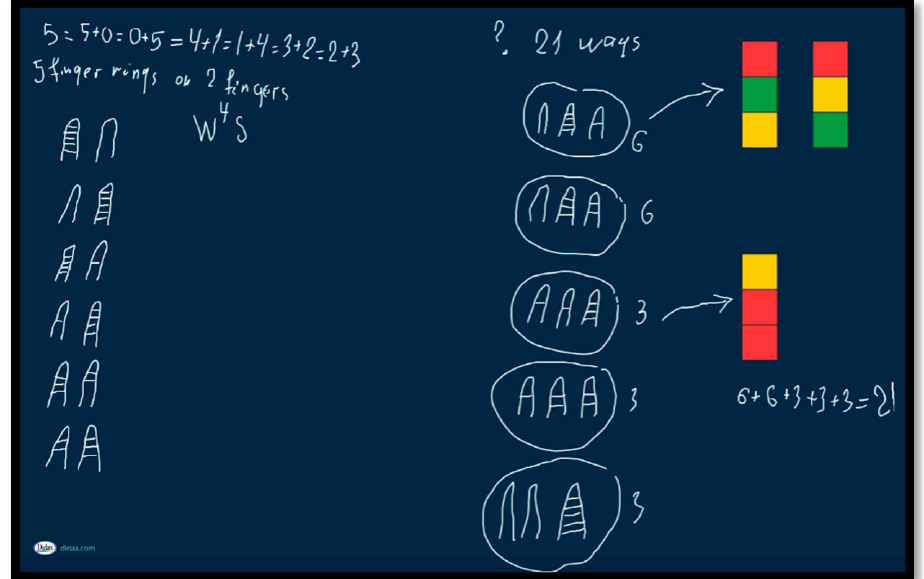
Figure 1. A screenshot from a class presentation of the question about three fingers.